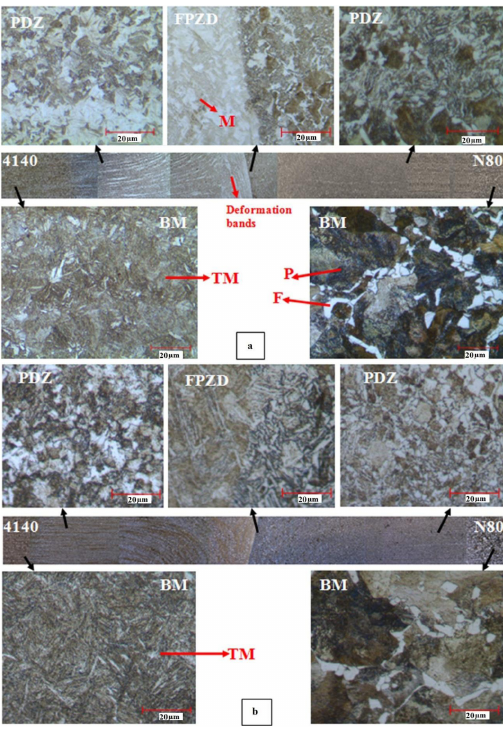
Figure 3. Microstructure of friction welded N80-42CrMo4 sample N80-42CrMo4 sample a) As-welded, b) Stress relief annealed (TM: Tempered martensite, M: Martensite, P: Perlite, F: Ferrite).